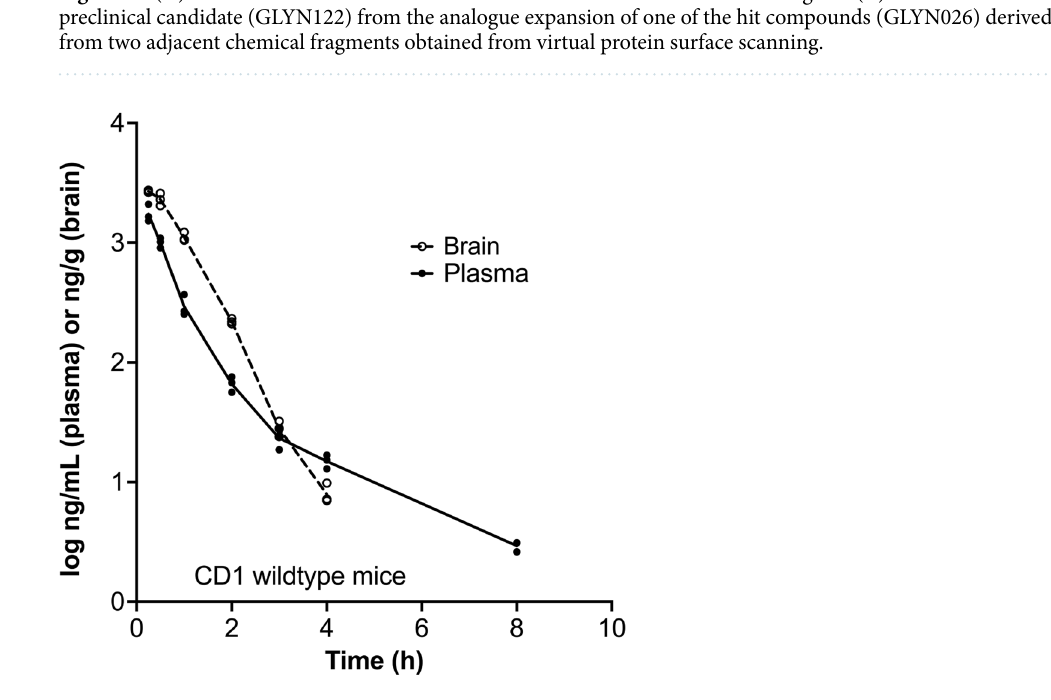
Figure 3. The concentration of GLYN122 that penetrated the blood–brain barrier of male CD1 mice (n = 3) treated with GLYN122 at a dose of 33.3 mg/kg body weight. Dashed line: brain, straight line: